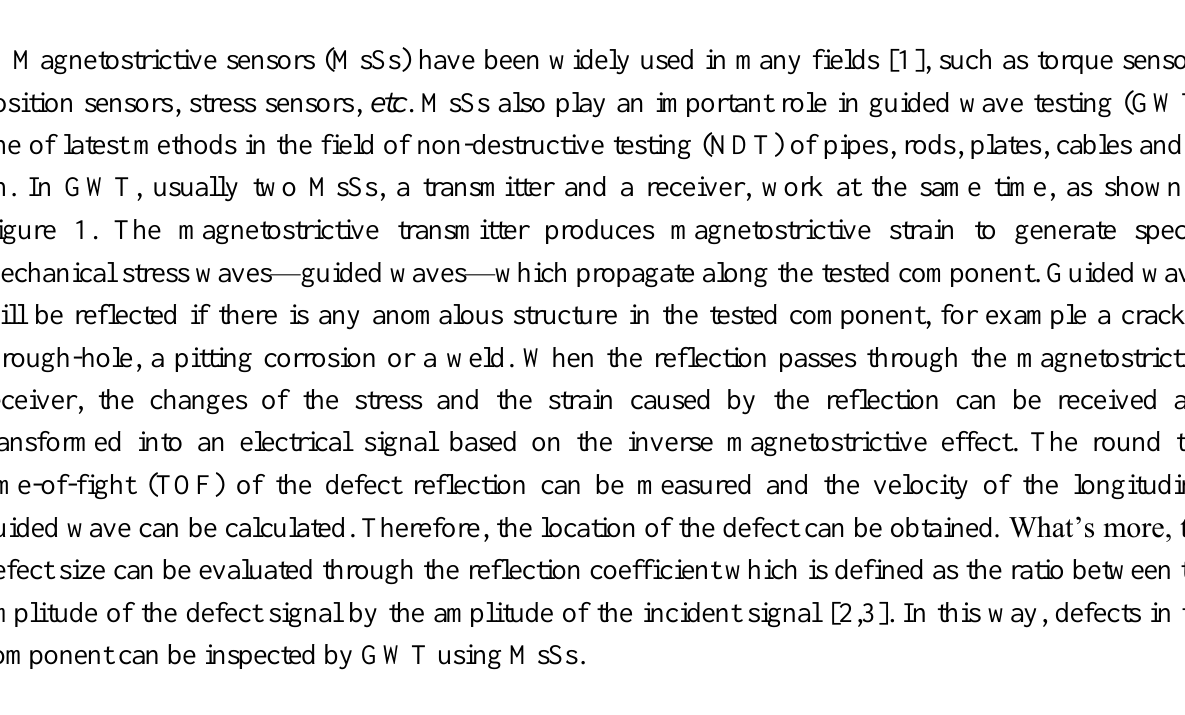
Figure 1. The principle of GWT using